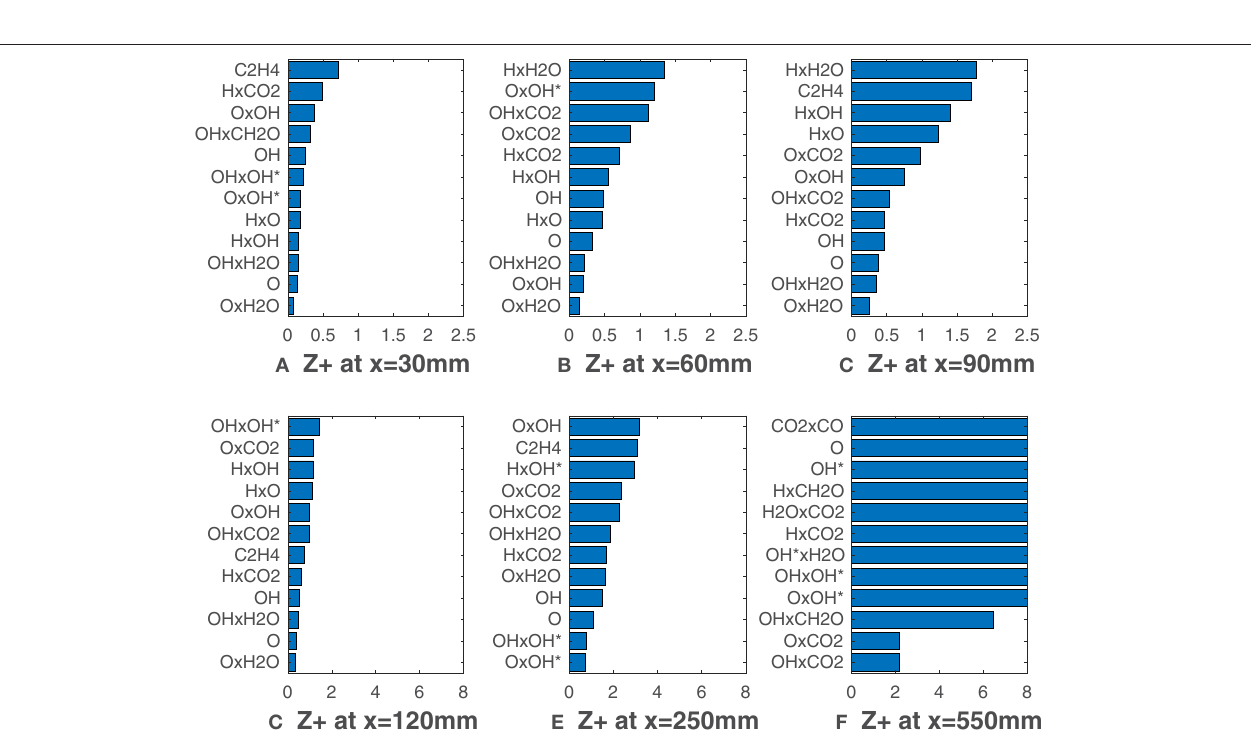
FIGURE 8 | HM3 case: best correlated markers at various axial locations. Lower Z + s ( ν ) values mean better correlation. Here ν comprehends both X α and their combinations.